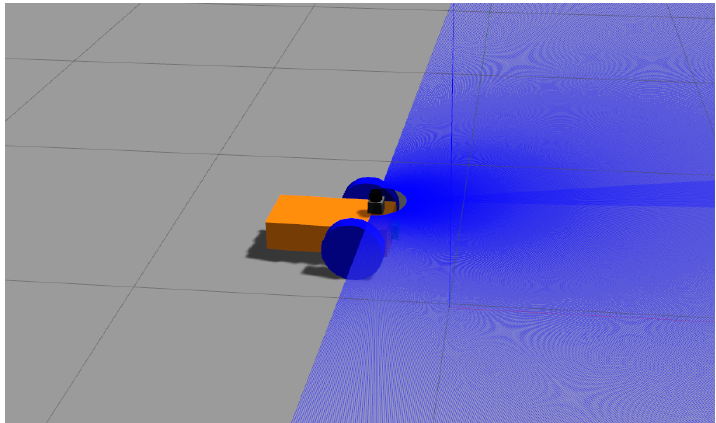
Figure 5. The Image of the Designed Robot in the Simulated